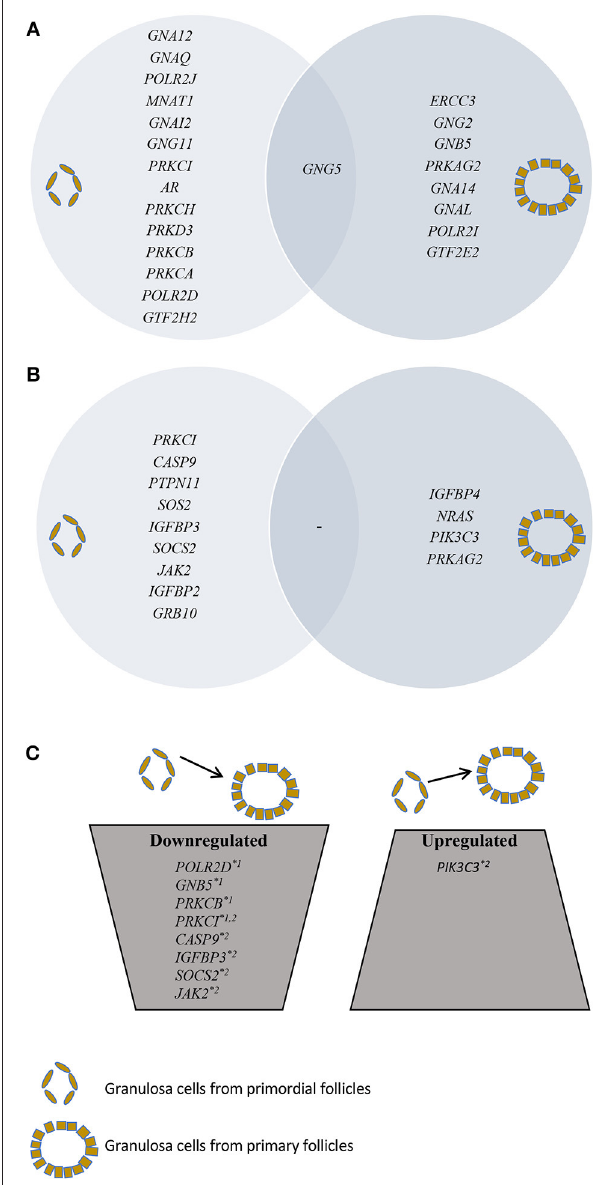
FIGURE 1 | Presentation of SSCEGs and DEGs in granulosa cells from primordial and primary follicles. (A) Presentation of SSCEGs from the “AR Signaling” Pathway that are significantly expressed in granulosa cell from primordial and primordial follicles, as indicated, and the number in the middle representing SSCEG in both stages. (B) Presentation of SSCEGs from the “IGF1 Signaling” Pathway that are significantly expressed in granulosa cell from primordial and primary follicles, as indicated, and number in the middle representing SSCEG in both stages. (C) Presentation of DEGs from both “AR Signaling” (Noted *1) and “IGF1 Signaling” (Noted *2)